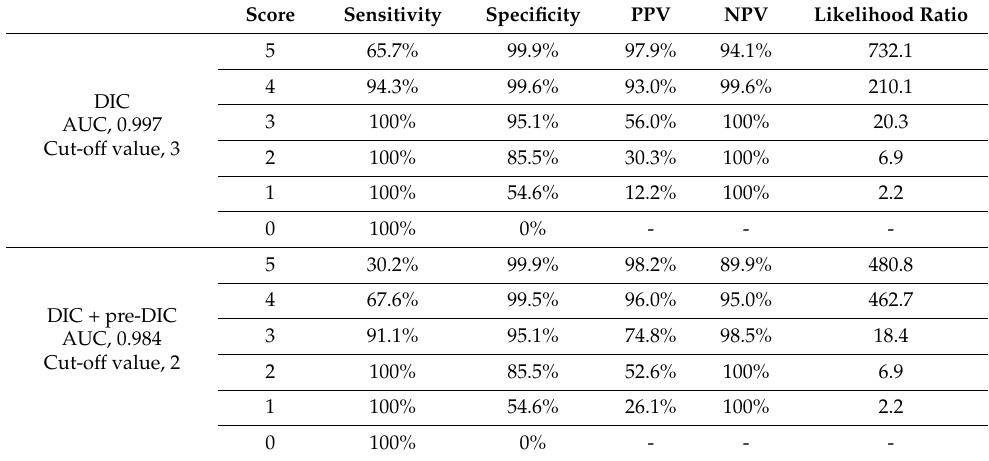
Table 5. Results of the ROC analysis of the quick DIC score for diagnosing DIC or pre-DIC vs. non-DIC.